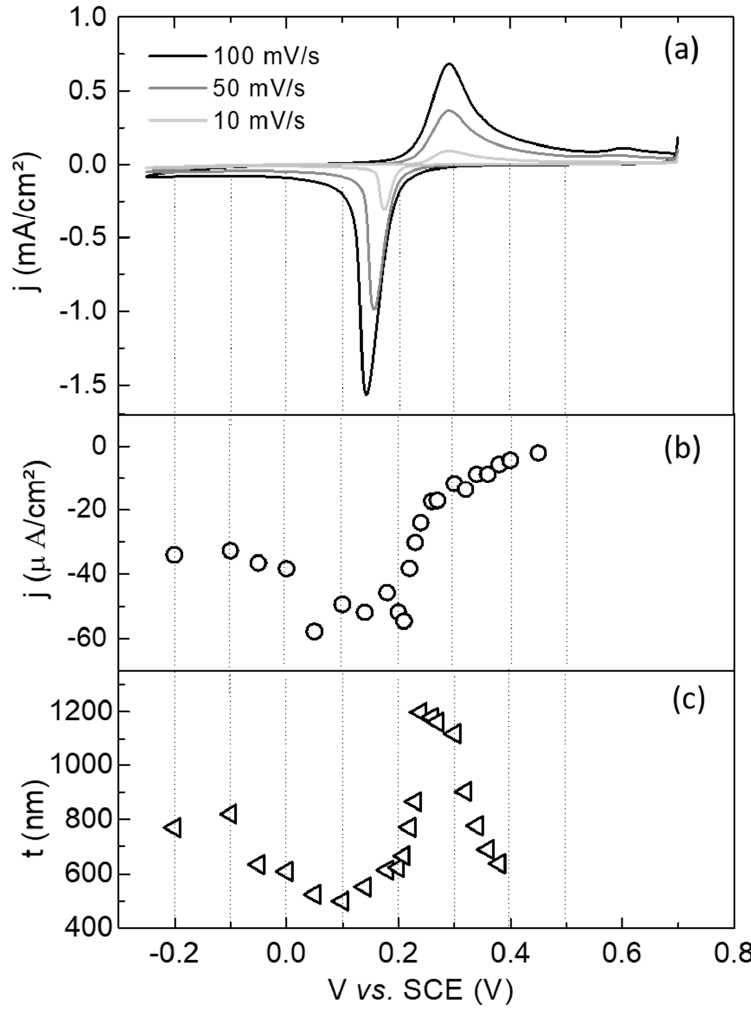
Figure 1. ( a ) Voltammetric curves at different scanning rates (10, 50, 100 mV/s) on Au/Si substrates. ( b ) Current densities at saturation and ( c ) thicknesses as a function of the applied constant potential for growing the layers.